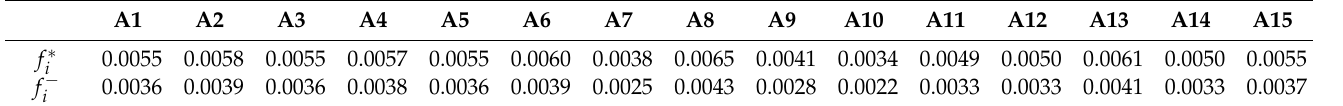
Table 10. Positive ideal solution and negative ideal solution of SCAIs.